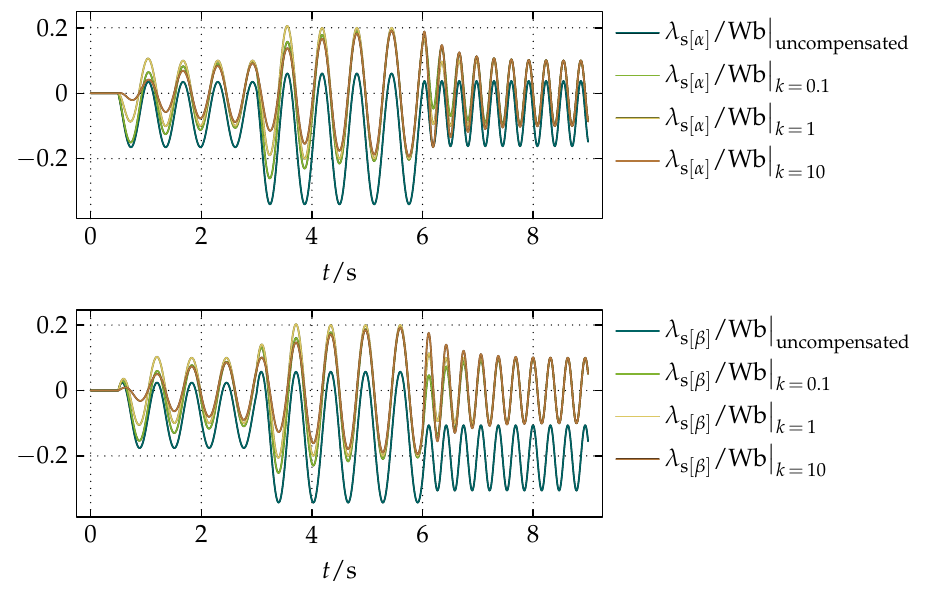
Figure 7. The resulting waveforms of λ s [ α ] and λ s [ β ] obtained by the simulation for ω c = 1000 rad and different values of k , including the uncompensated case equivalent to k = 0.